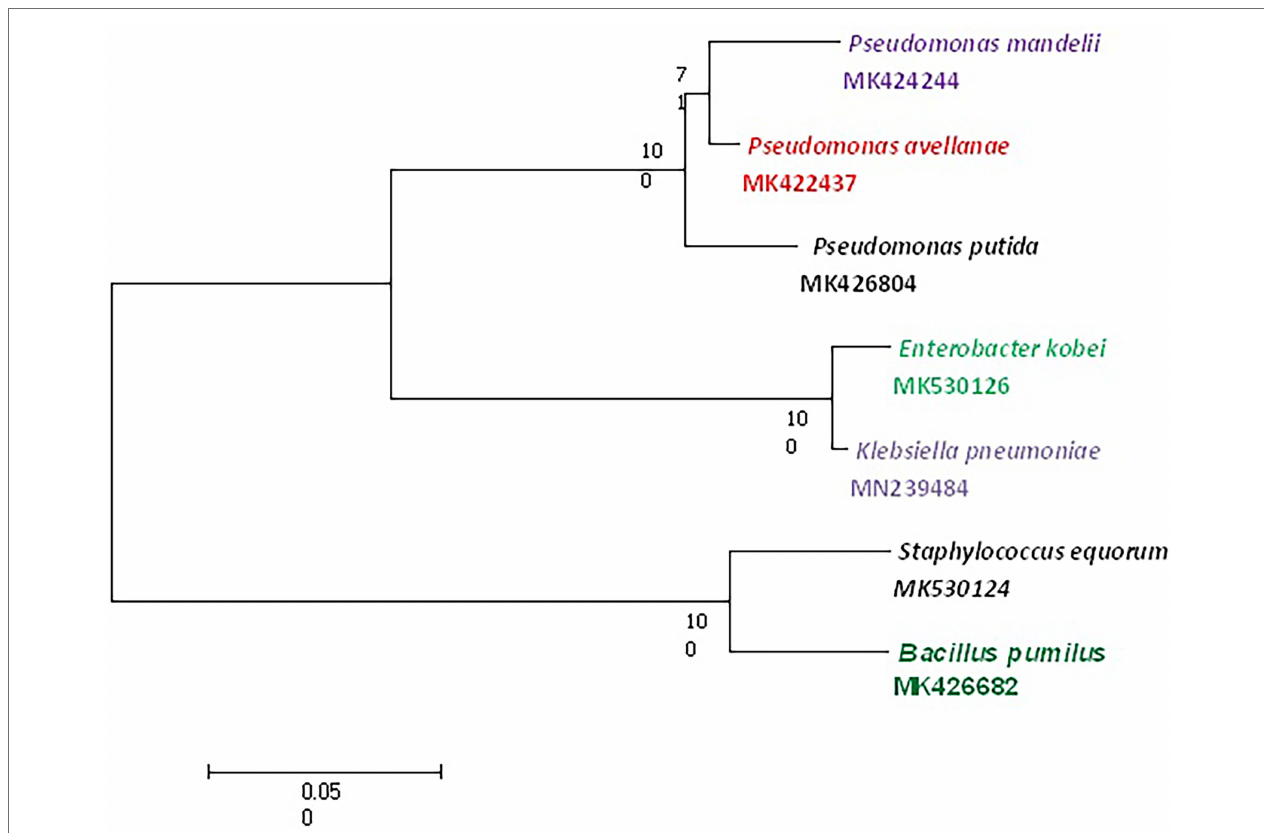
FIGURE 3 | Phylogenetic analysis of the cadmium tolerant isolates obtained in this study.